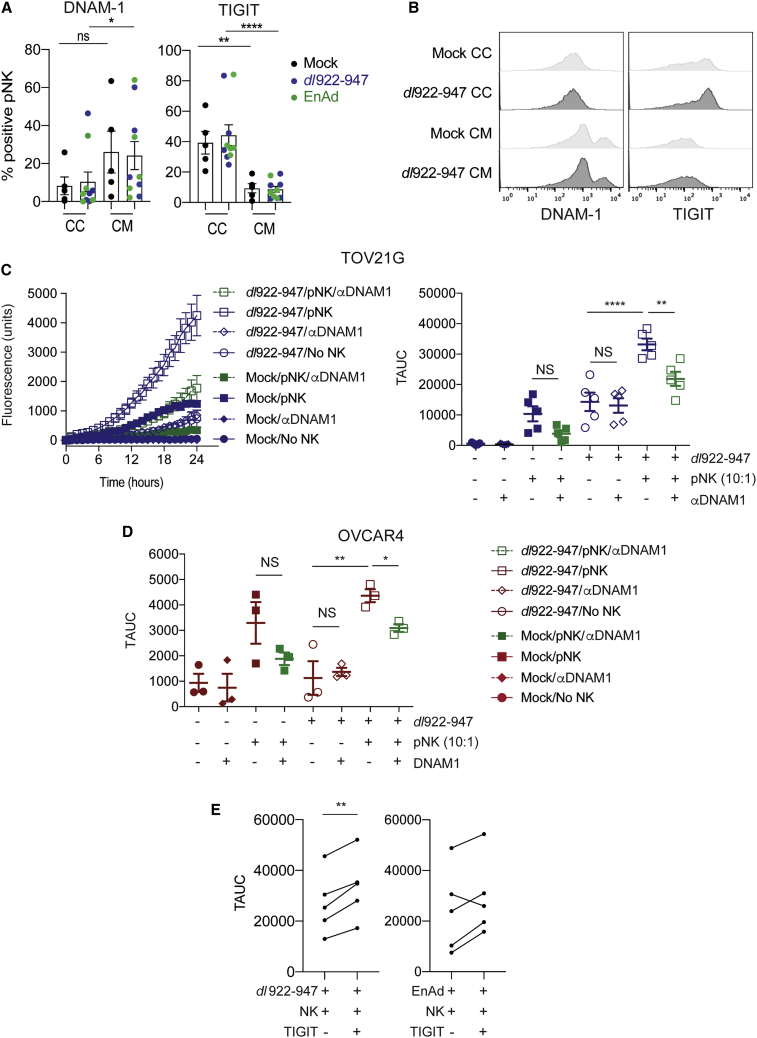
DNAM-1 Blockade Attenuates and TIGIT Blockade Augments NK-Mediated Cytotoxicity against Adenovirus-Infected CellsThe changes of NK receptors on pNK after exposure to adenovirus-infected TOV21G or their conditioned media were evaluated by flow cytometry. (A) Summary analyses of independent experiments (n = 5) for DNAM-1 (left) and TIGIT (right) expression. (B) Representative images of DNAM-1 (left) and TIGIT (right) expression (Mann-Whitney U tests; CC, co-culture; CM, conditioned-medium). pNK were co-cultured with dl922-947-infected cells with or without a blocking anti-DNAM-1 antibody (10 μg/mL) and assessed by time-lapse microscopy. (C) Representative data of fluorescent object counts over time for TOV21G (left) and summary data (n = 5) of TAUC for TOV21G (right) and (D) OVCAR4 (n = 3) are shown (one-way ANOVA with multiple comparisons test). (E) pNK were co-cultured with OV-infected TOV21G cells with or without a blocking anti-TIGIT antibody (20 μg/mL) and assessed by time-lapse microscopy (n = 5, each line represents a unique donor; also see Figure S8).